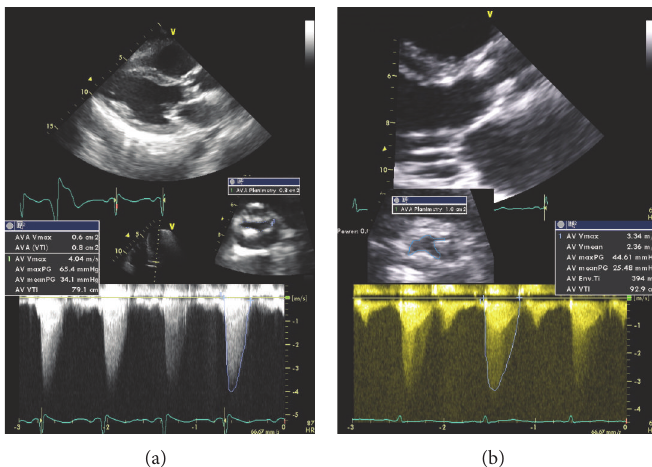
Figure 2: Transthoracic echocardiography before and after valvuloplasty shows a calcified, stenotic aortic valve with AVA of 0.8 cm 2 by planimetry and continuity equation (VTI). Postvalvuloplasty there is demonstrated improvement in aortic valve gradients as well as AVA.